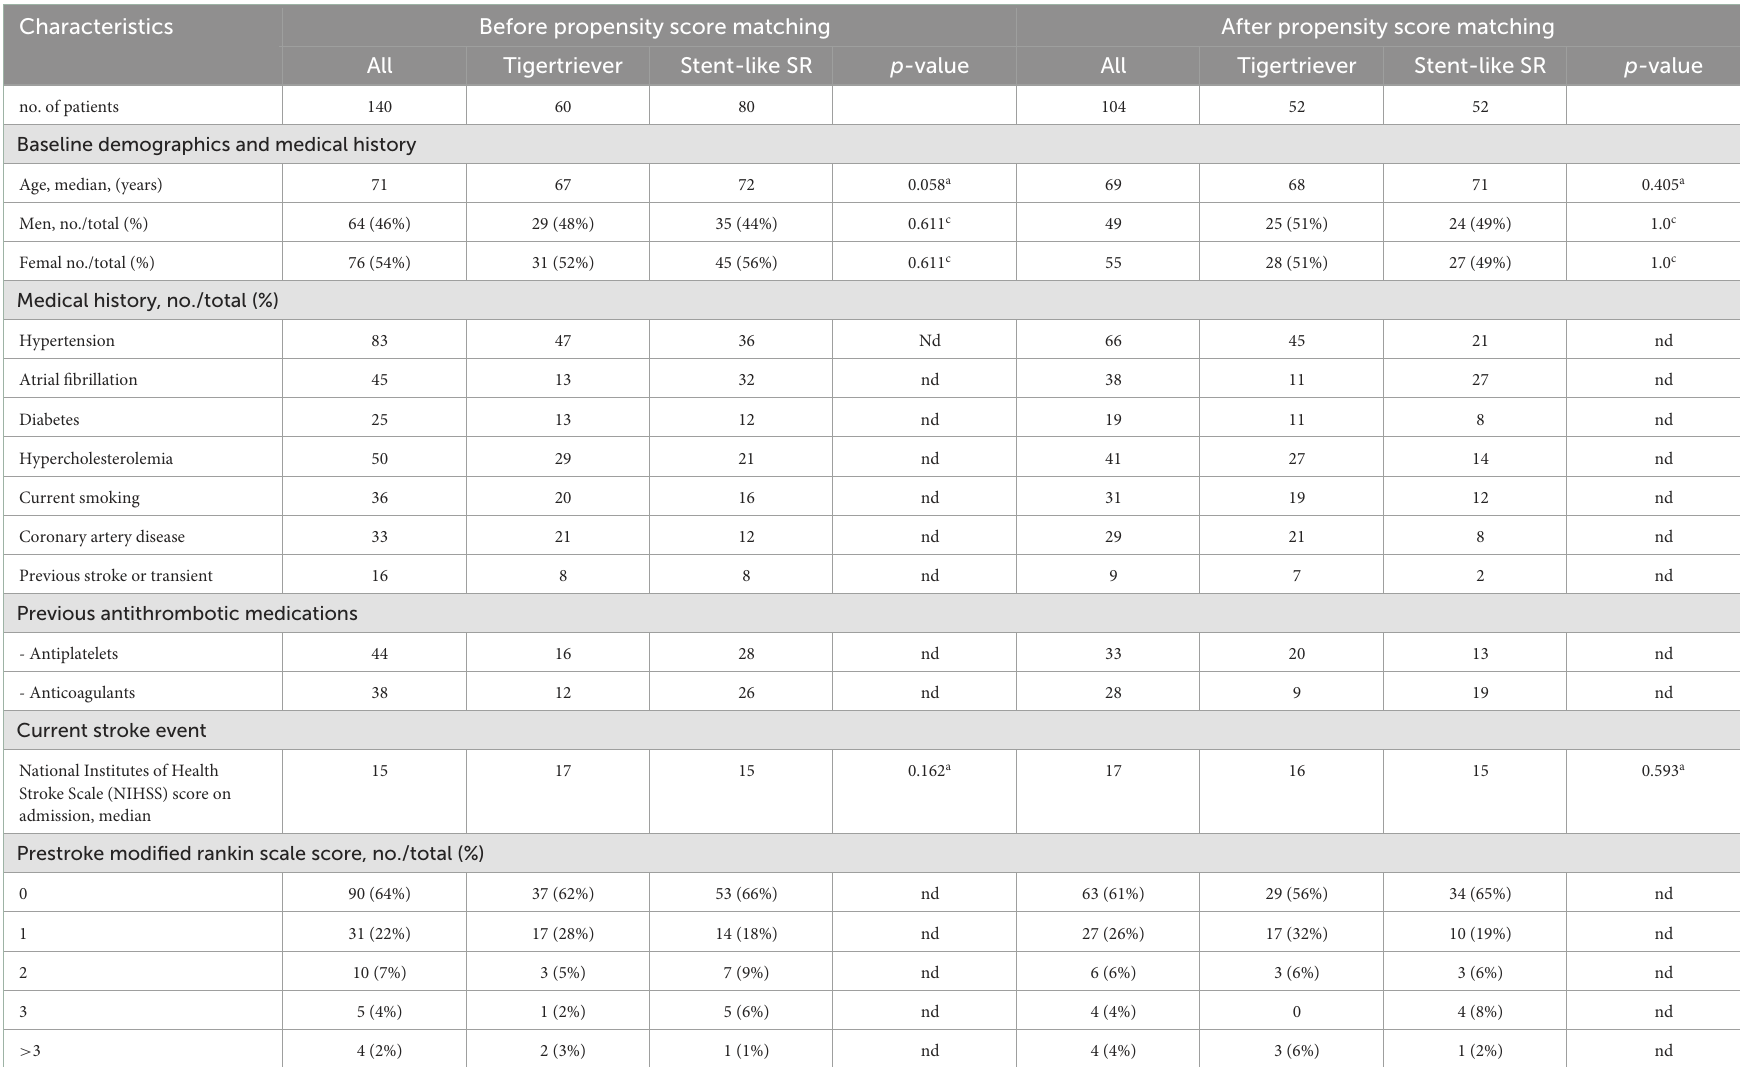
TABLE 1 Patients’ baseline characteristics and treatment results. Characteristics Before propensity score matching After propensity score matching All